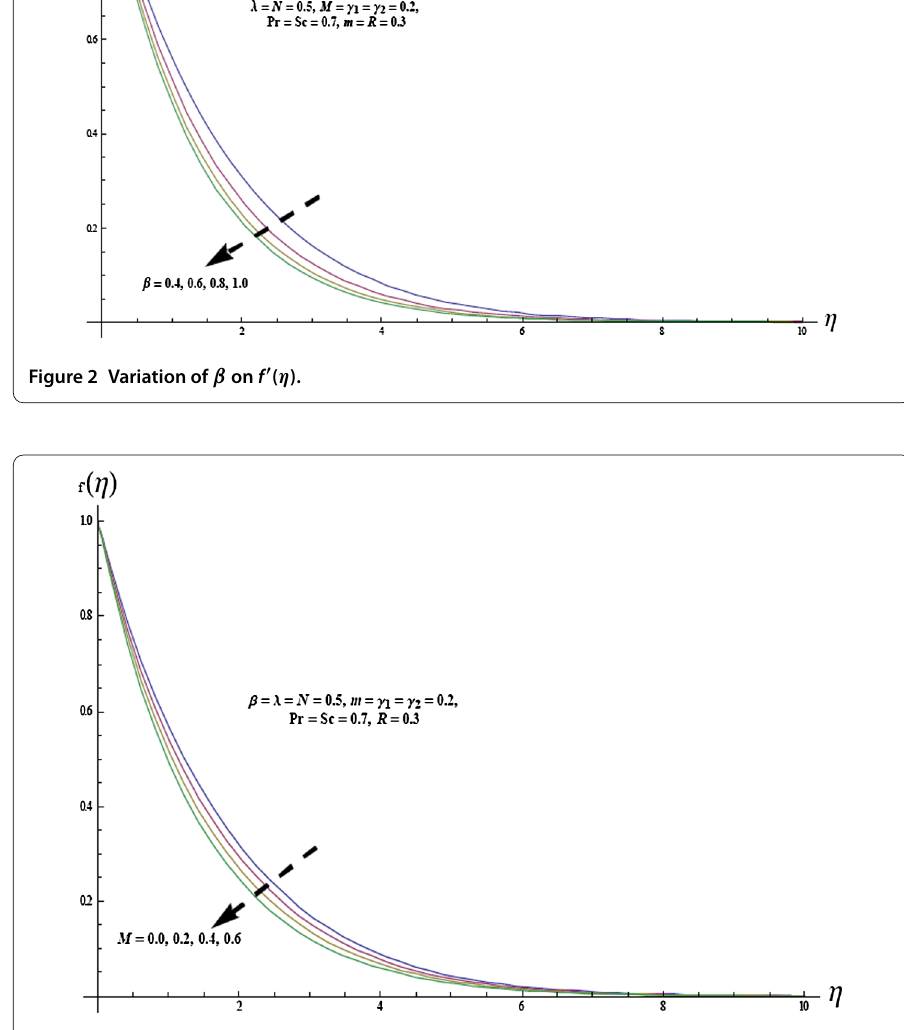
Figure 3 Variation of M on f (cid:2) ( η ).